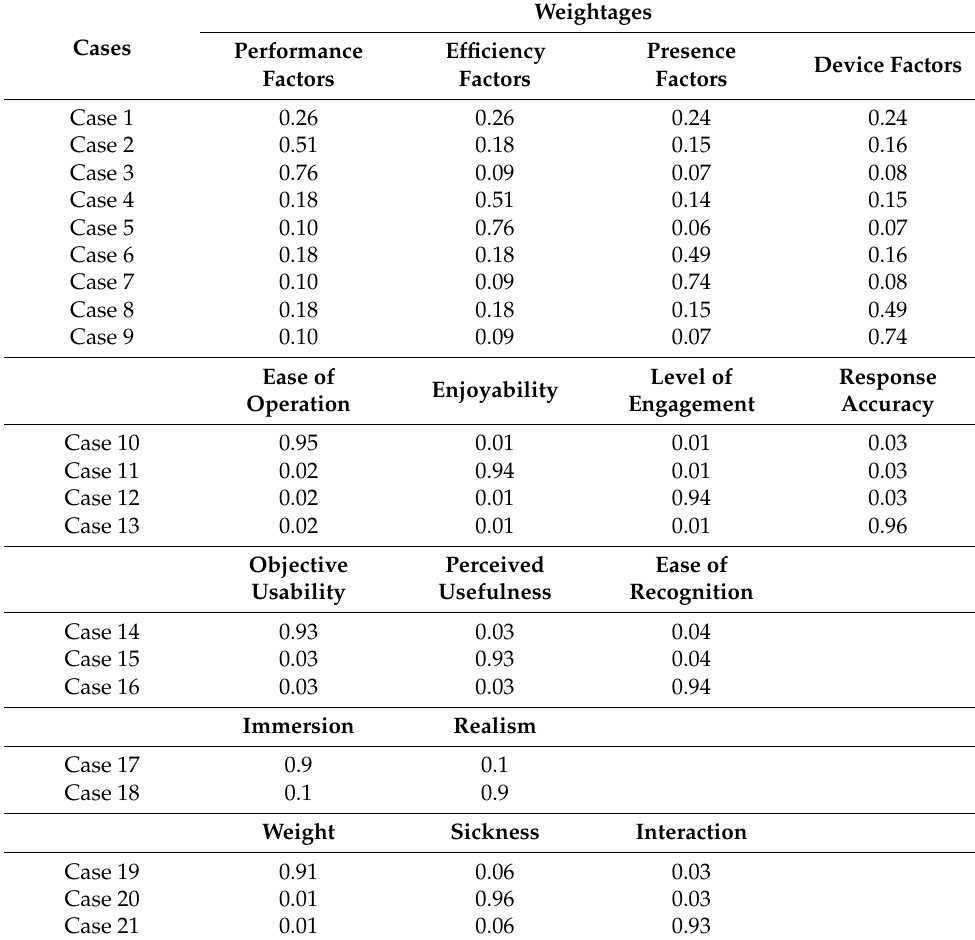
Table 12. Sensitivity Analysis Case